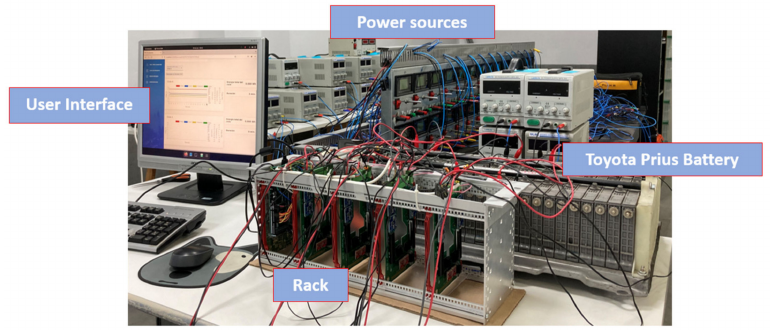
Figure 10. Toyota Prius battery and proposed system prototype. General